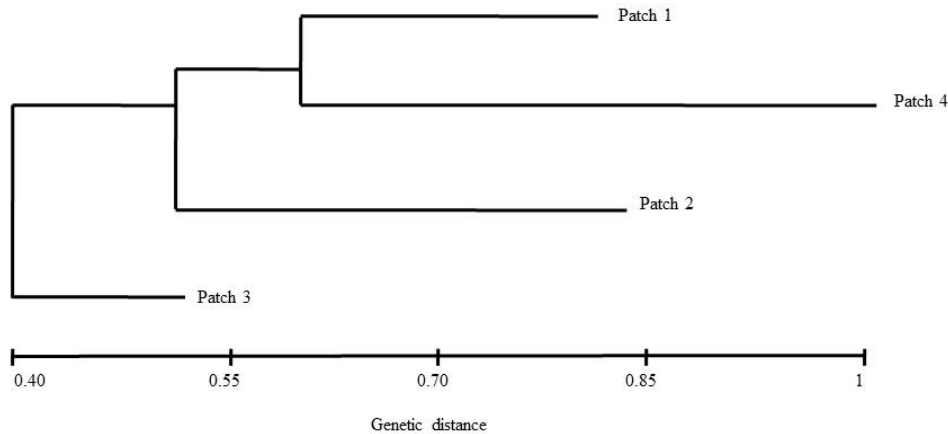
Figure 4. The cluster that describes the genetic relationships among patches constructed with the UPGMA model.